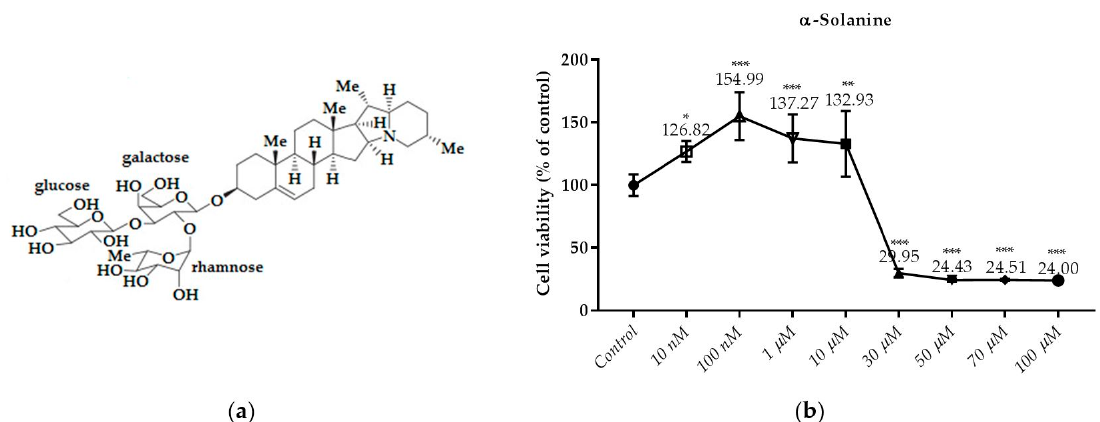
Figure 6. Dose dependent cytotoxic effects of α -solanine was determined by SRB assay and shown for 24 h: ( a ) The molecular structure of α -solanine; ( b ) Effect of α -solanine on viability of RL95-2 cell. Cells were treated with various concentrations of α -solanine for 24 h. Cell viability is presented as mean ± SD at least three independent experiments. ** p < 0.01 and *** p < 0.001 compared with the untreated control.